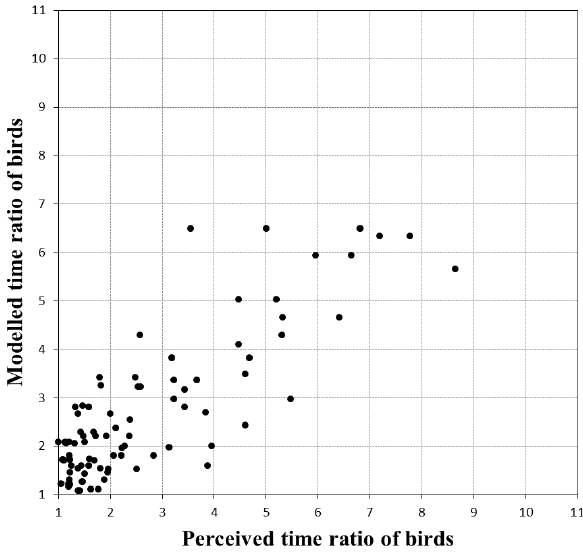
Figure 8: Relation between the perceived time ratio of voices and this time ratio modelled by the Eq.